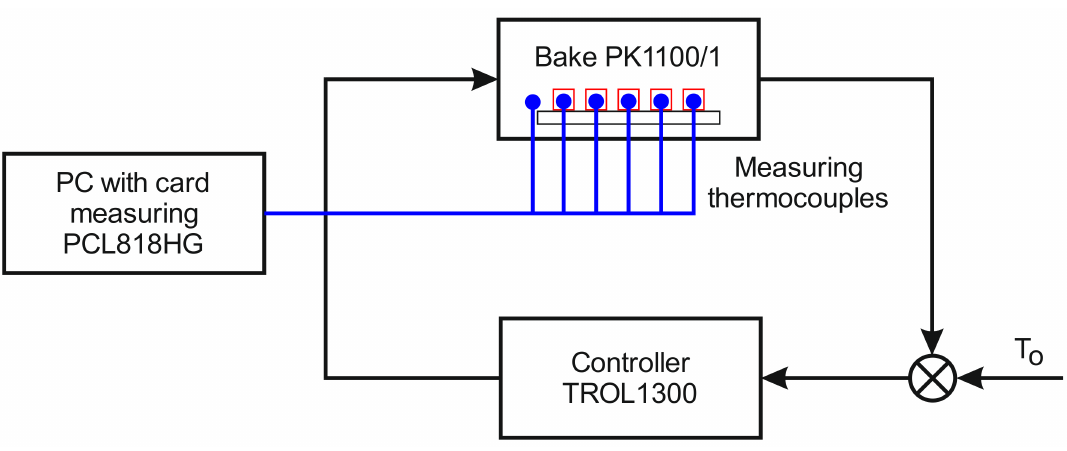
Figure 1. The scheme of the test stand for heating.